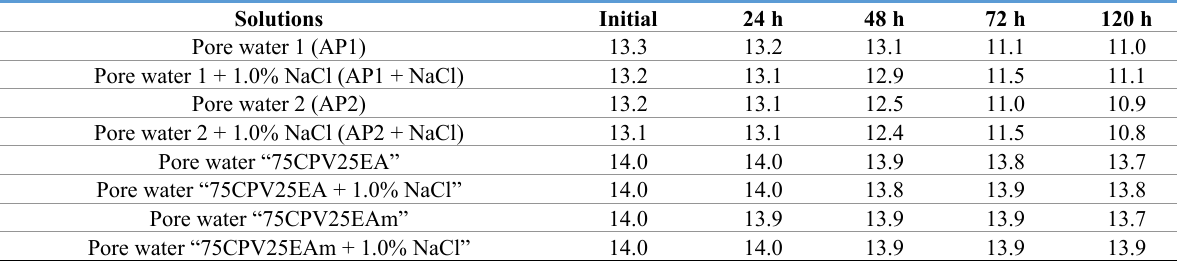
Table 6. pH monitoring of pore water during impedance